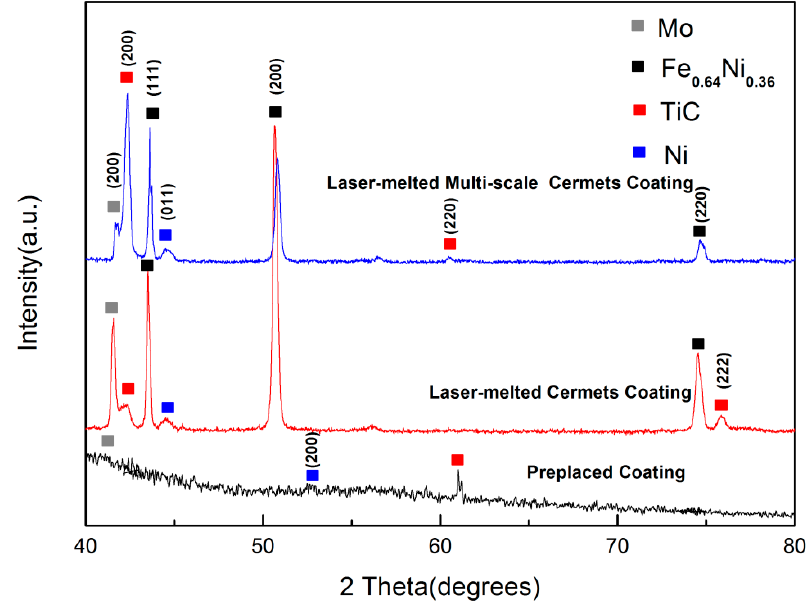
Figure 1. XRD patterns of the preplaced coating, cermet coating, and multi-scale cermet coating prepared by laser cladding.